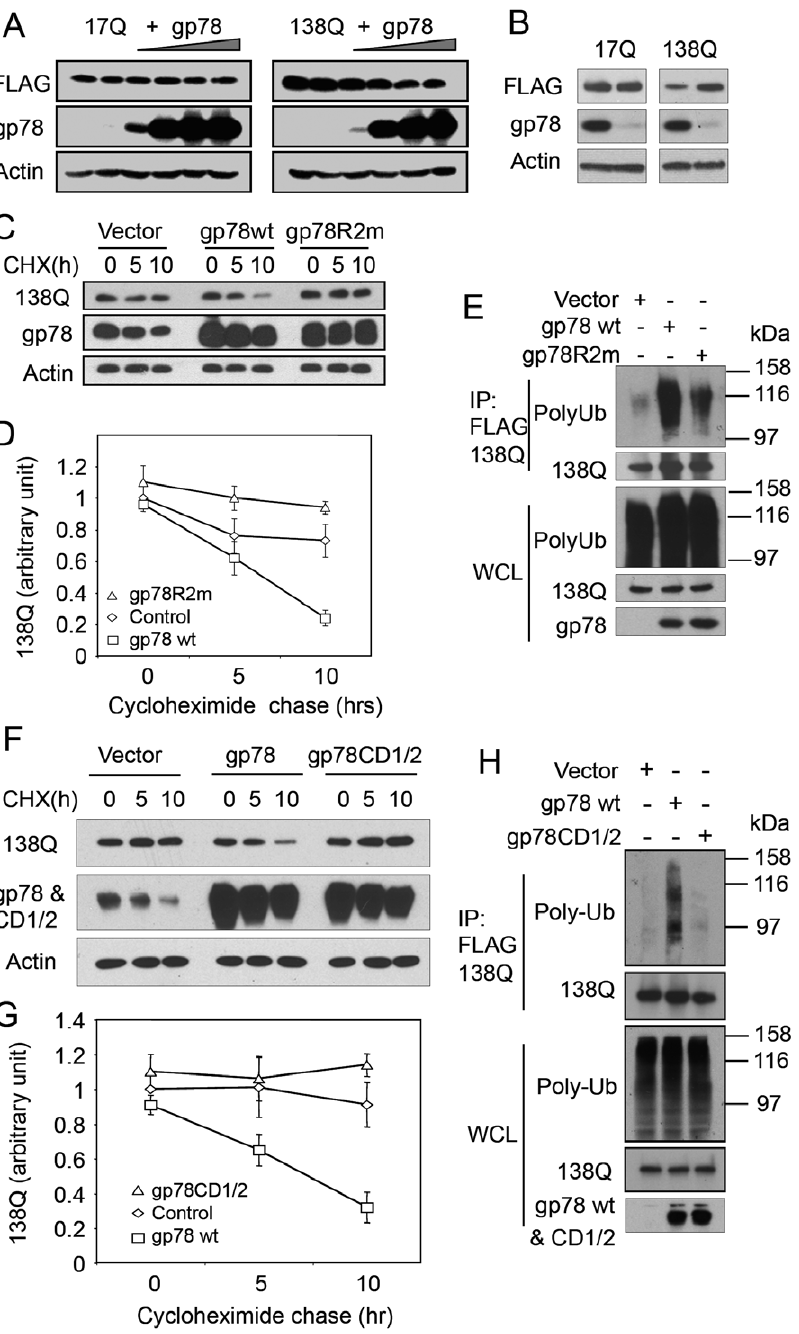
Figure 8. gp78 ubiquitinates and targets Nhtt138Q but not Nhtt17Q for degradation dependent on its RING finger and cue domain. A. Overexpression of gp78 decreases the levels of Nhtt138Q but not Nhtt17Q protein. Increasing amounts of gp78 were expressed in HEK293 cells that had been transfected with Nhtt17Q or Nhtt138Q. 24 h after gp78 transfection, cells were processed for immunoblotting for the indicated proteins. B. Knockdown of gp78 stabilizes Nhtt138Q but not Nhtt17Q. gp78 was knocked down by RNAi in HEK293 cells expressing Nhtt138Q or Nhtt17Q. 2 days after the knockdown cells were processed for immunoblotting for gp78 and Nhtt17Q and Nhtt138Q. Actin was blotted as a loading control. C. gp78 enhances Nhtt138Q degradation, which requires an intact RING finger. HEK293 cells transfected as indicated were subjected to cycloheximide (CHX) chase. Nhtt138Q degradation was quantified and expressed as mean + / 2 SD, n =3, in D. E. gp78 ubiquitinates Nhtt138Q. Nhtt138Q-expressing HEK293 cells were transfected with wt gp78, or gp78R2m, or empty vector as a control. Nhtt138Q was immunoprecipitated with anti-FLAG antibody. Precipitates were processed for immunoblotting for ubiquitin. F - H. Cue domain is required for gp78 to ubiquitinate and target Nhtt138Q for degradation. Wt gp78, gp78CD1/2, or empty vector-transfected HEK293 cells were subjected to analysis as described in C–E.